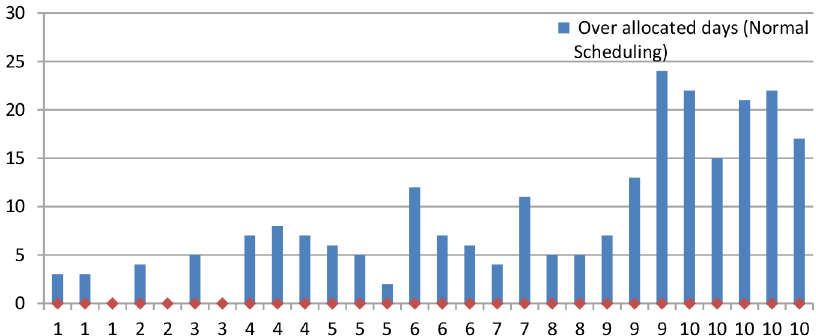
Figure 58. Comparing number of over allocated days for the solved experiments